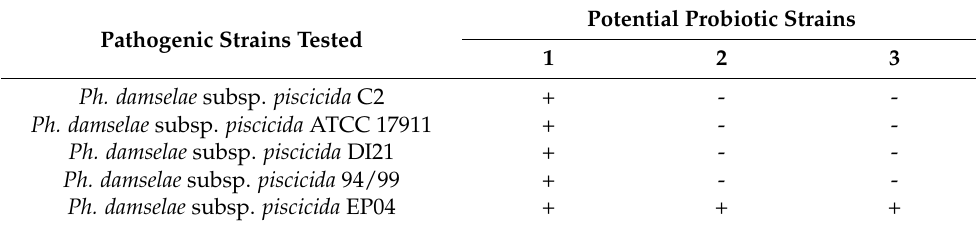
Table 3. In vitro antagonistic effect and identification of potential probiotic strains isolated